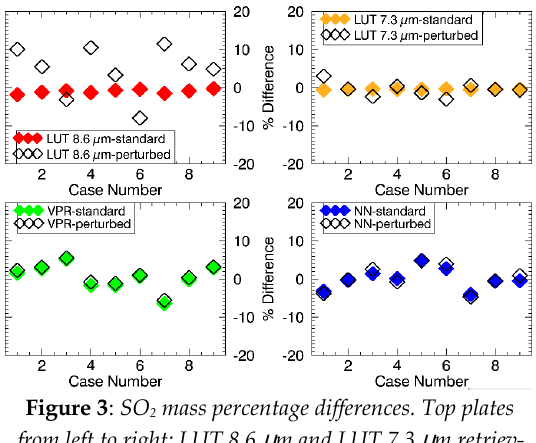
Figure 3 : SO 2 mass percentage differences. Top plates from left to right: LUT 8.6 m m and LUT 7.3 m m retriev- als. Bottom plates from left to right: VPR and NN re-